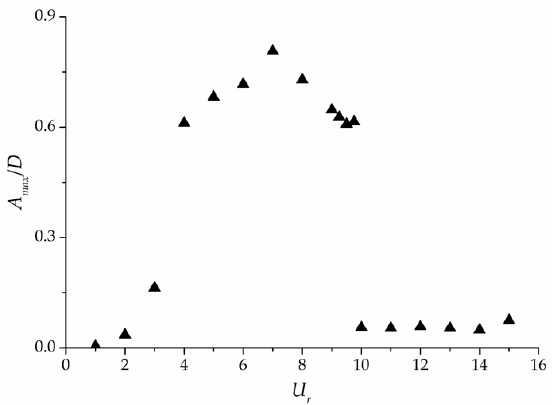
Figure 9. Vibration mode and wake vortex shedding mode of SFT in one cycle when reduced velocity U r = 2.0 (Re = 50,000, m * = 2.5, ξ = 0.007).